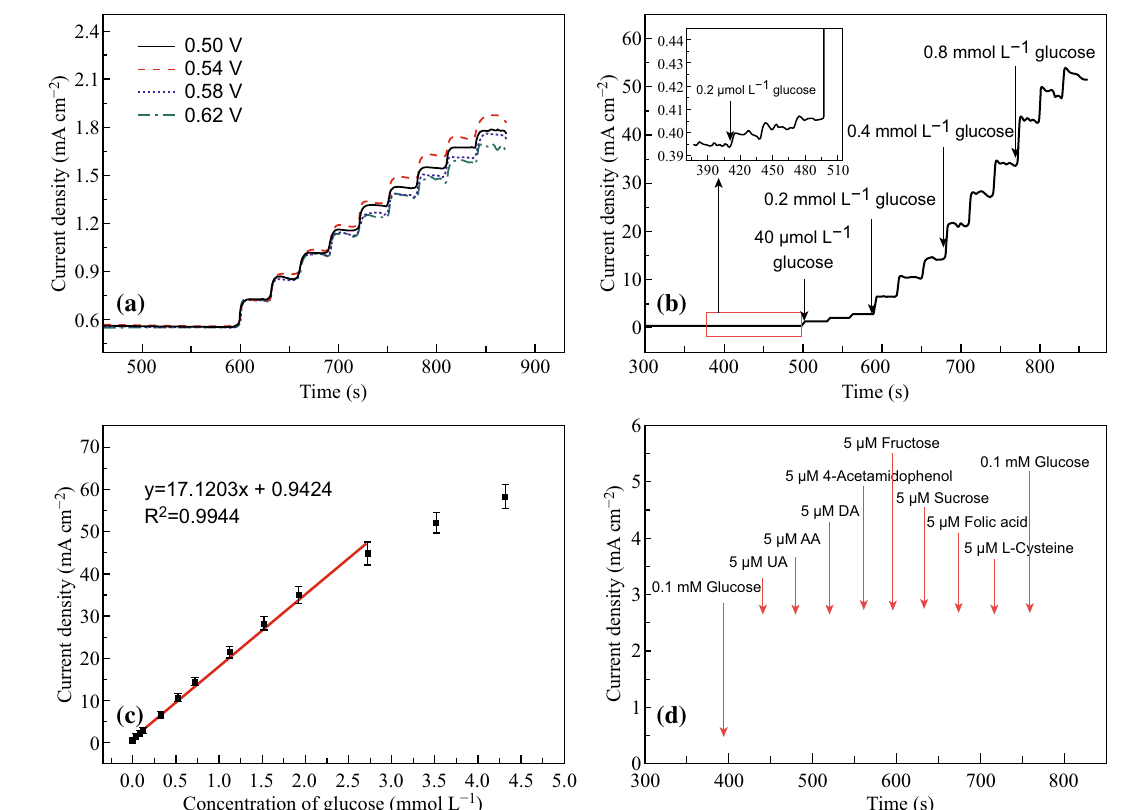
Fig. 6 a Effects of various potentials on the amperometric response of CuNi/C electrodes given the successive addition of 8 μ M glucose. b Amperometric responses of CuNi/C electrodes given the successive addition of glucose at 0.54 V. The left inset shows partial amplification of the amperometric response to low glucose concentration. c The corresponding calibration curve of the response current density relative to glucose concentration. d Interference test performed on CuNi/C electrodes by adding 0.1 mM glucose, 5 μ M DA, 5 μ M AA 52 μ M UA, 5 μ